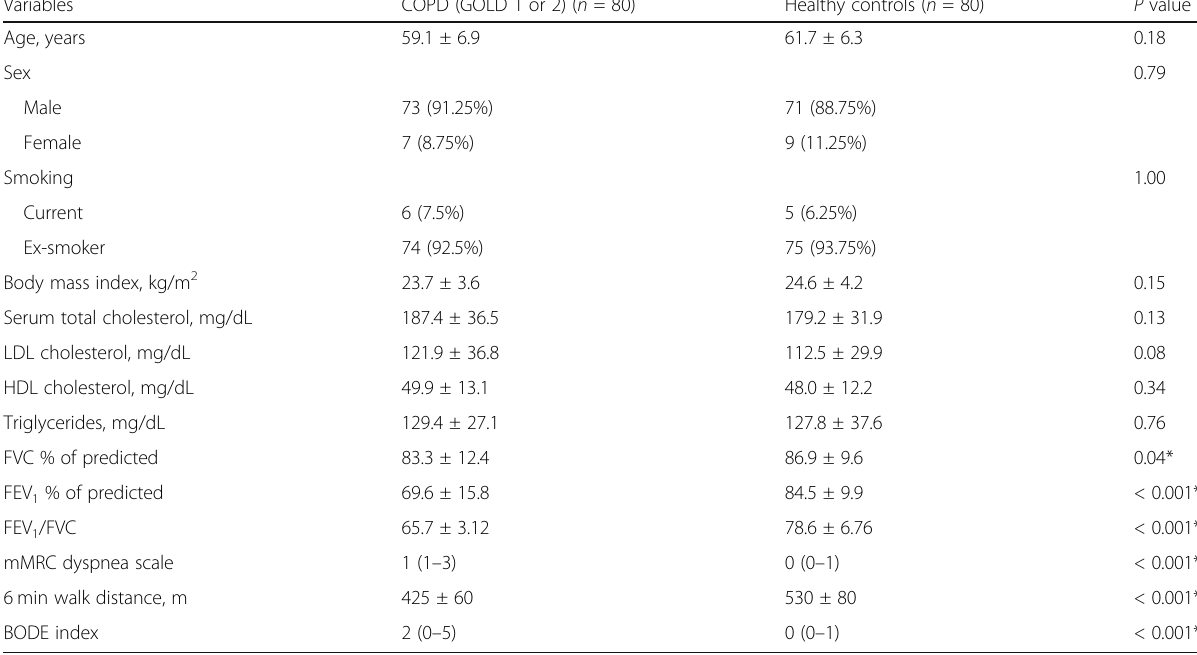
Table 1 Characteristics of all studied